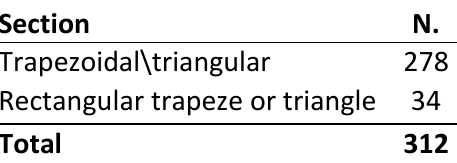
Table 4. Section of target